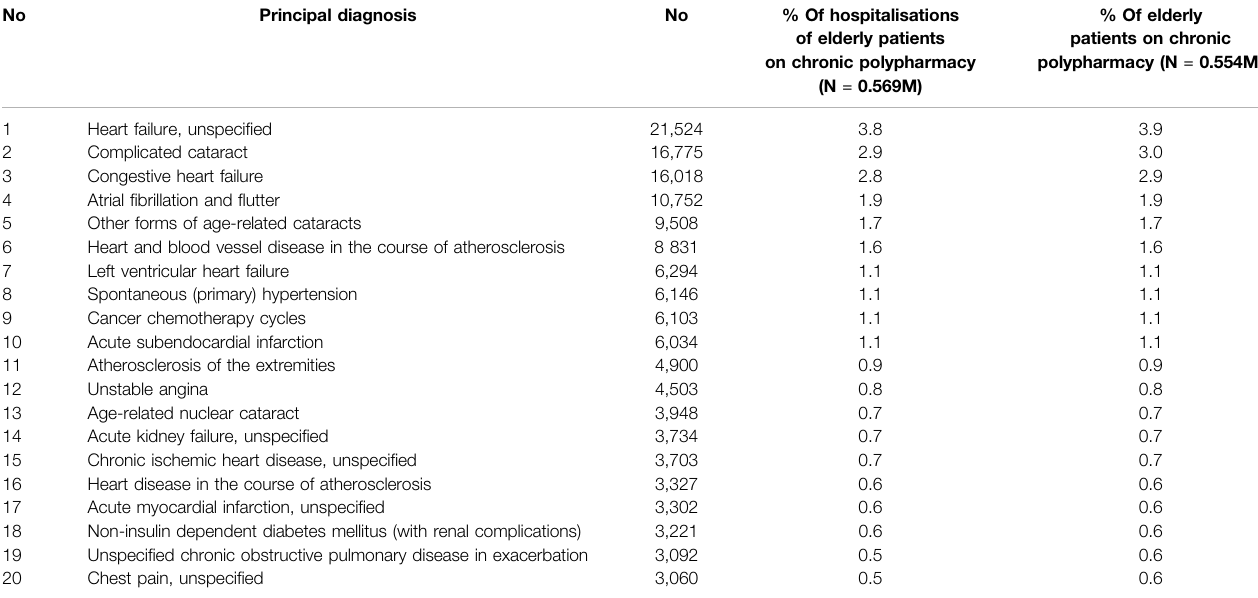
TABLE 5 | Principal diagnoses of hospitalisations in elderly people on chronic polypharmacy in